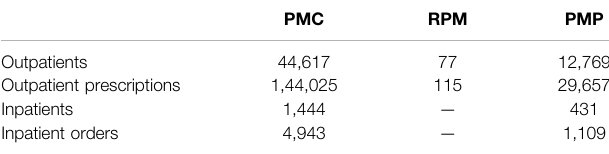
TABLE 1 | Outpatient and inpatient data of PMC, RPM, and PMP.